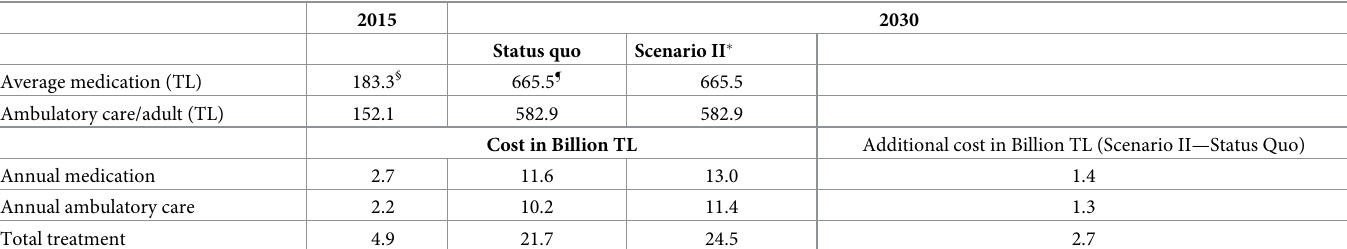
Table 8. Estimated hypertension treatment costs, 2015 and 2030.